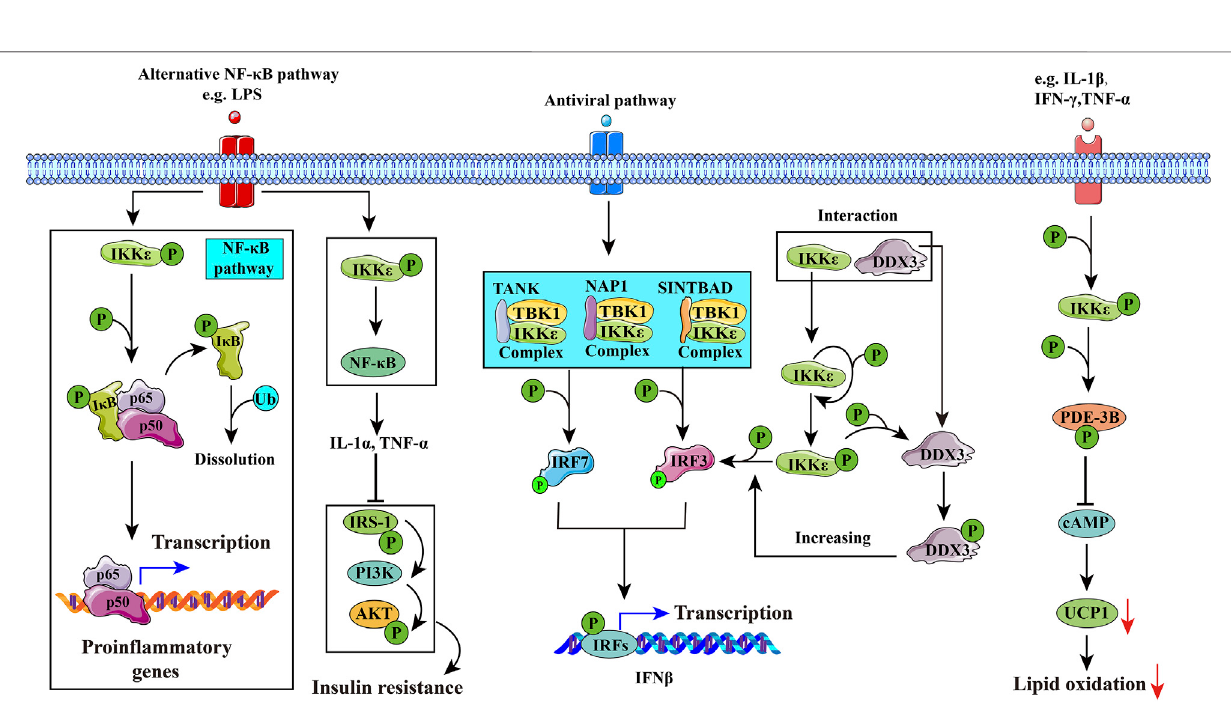
Frontiers in Pharmacology |